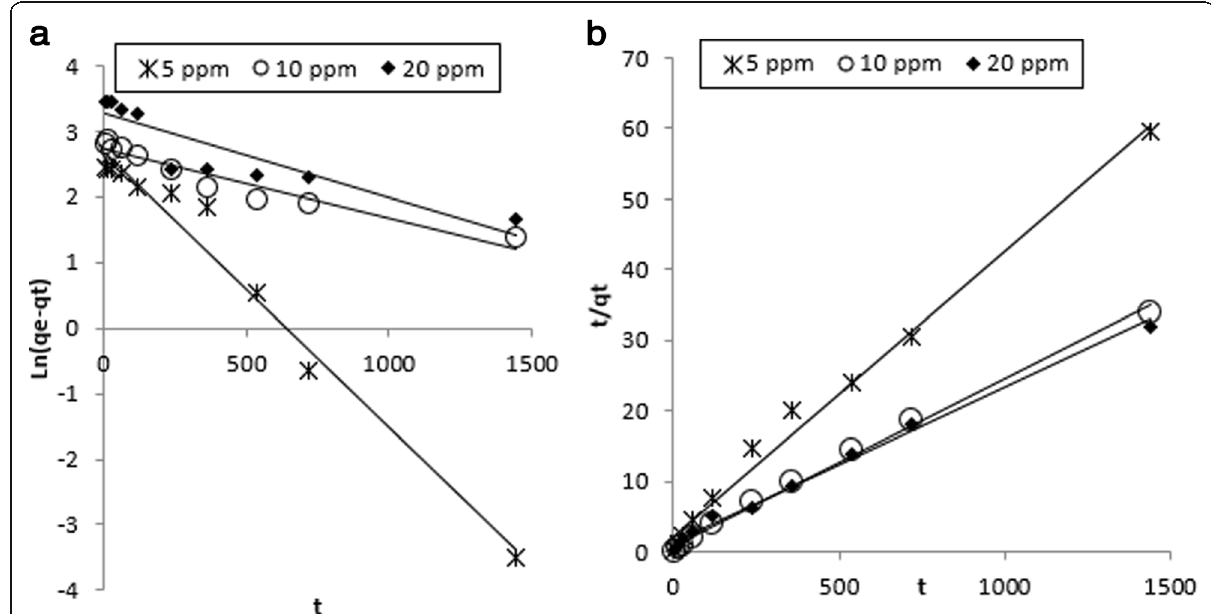
Fig. 14 Adsorption kinetics data of Cr (VI) on N6,6/GO for different initial metal concentrations. a Pseudo-first-order. b